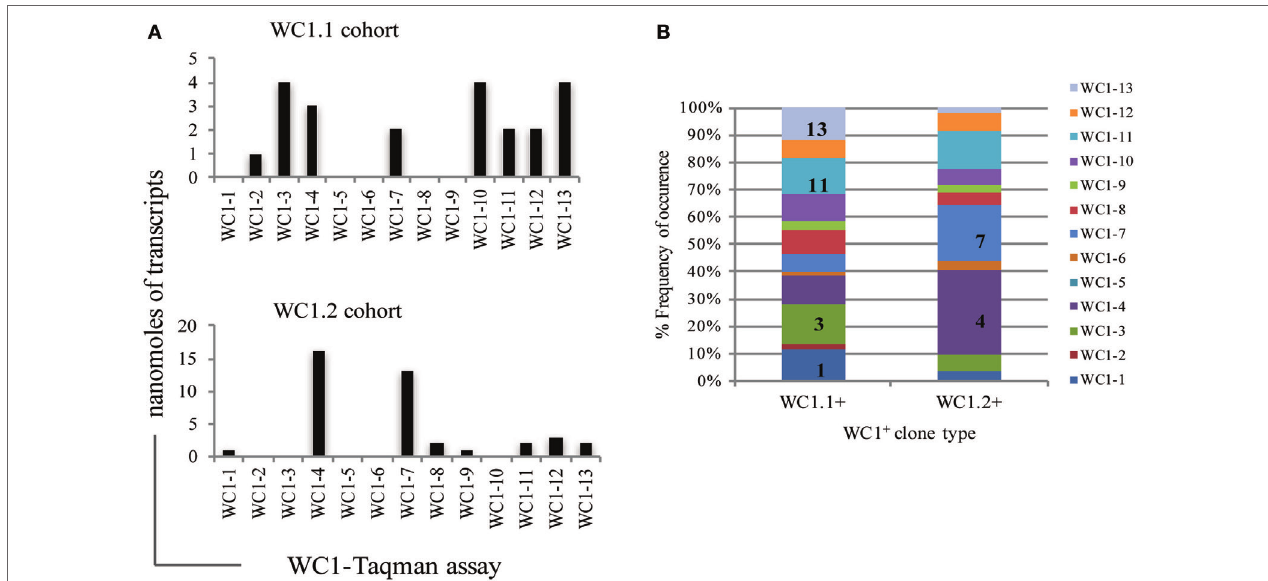
FigUre 6 | Diversity index of individual WC1 gene transcription by γδ T cell clones in each WC1 cohort. (a) For each clone the predominately expressed WC1 gene, based on highest mean transcript level, was noted and the total number of times a WC1 gene was the predominant is plotted. (b) Diversity index shows the percentage of times transcripts for the WC1 genes occurred in a cohort of clones ( y -axis). WC1 genes most frequently transcribed within the repertoire of WC1 transcripts is indicated as a number x (e.g., WC1- x ) in appropriate boxes to add